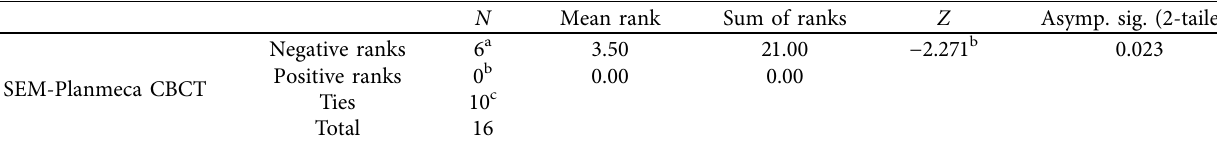
Table 4: Comparison of marginal leakage scores between Planmeca CBCT unit and